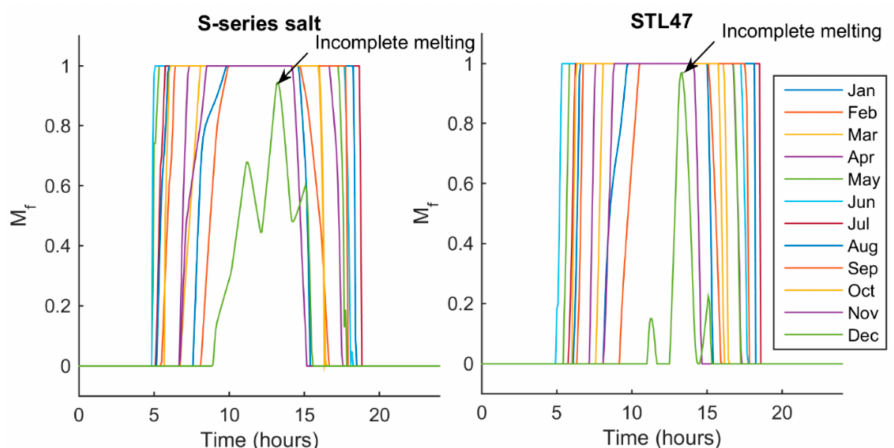
Figure 10. Melt fraction of S-series salt and STL47 for all months of a